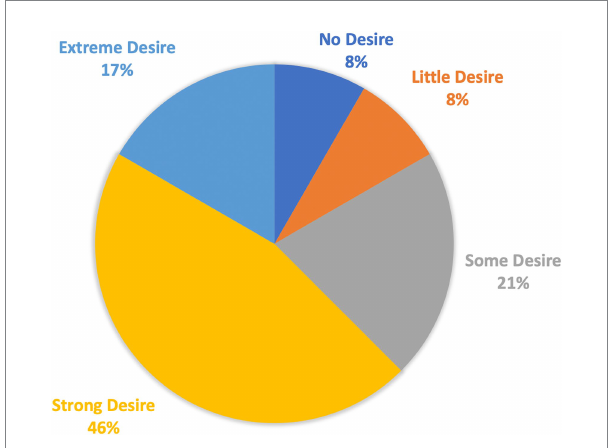
FIGURE 2 Students’ satisfaction after the study. A survey was conducted among students to assess their satisfaction with their participation in the study. The graph shows the percentage of students who expressed a desire to participate in another